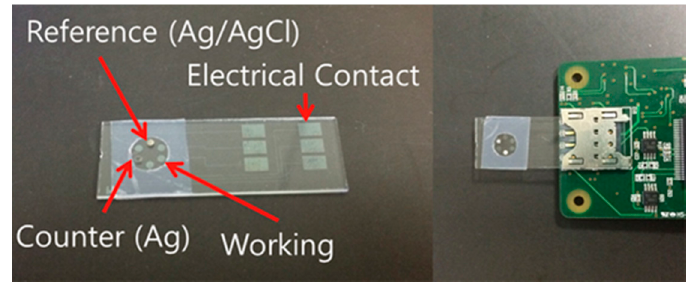
Figure 4. Patterned electrodes fabricated using indium tin oxide (ITO) glass.